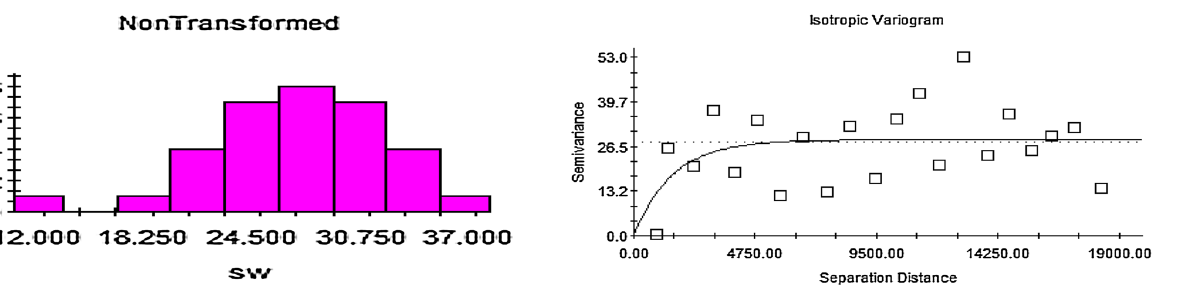
Fig. 5 Variogram diagram related to the water saturation data